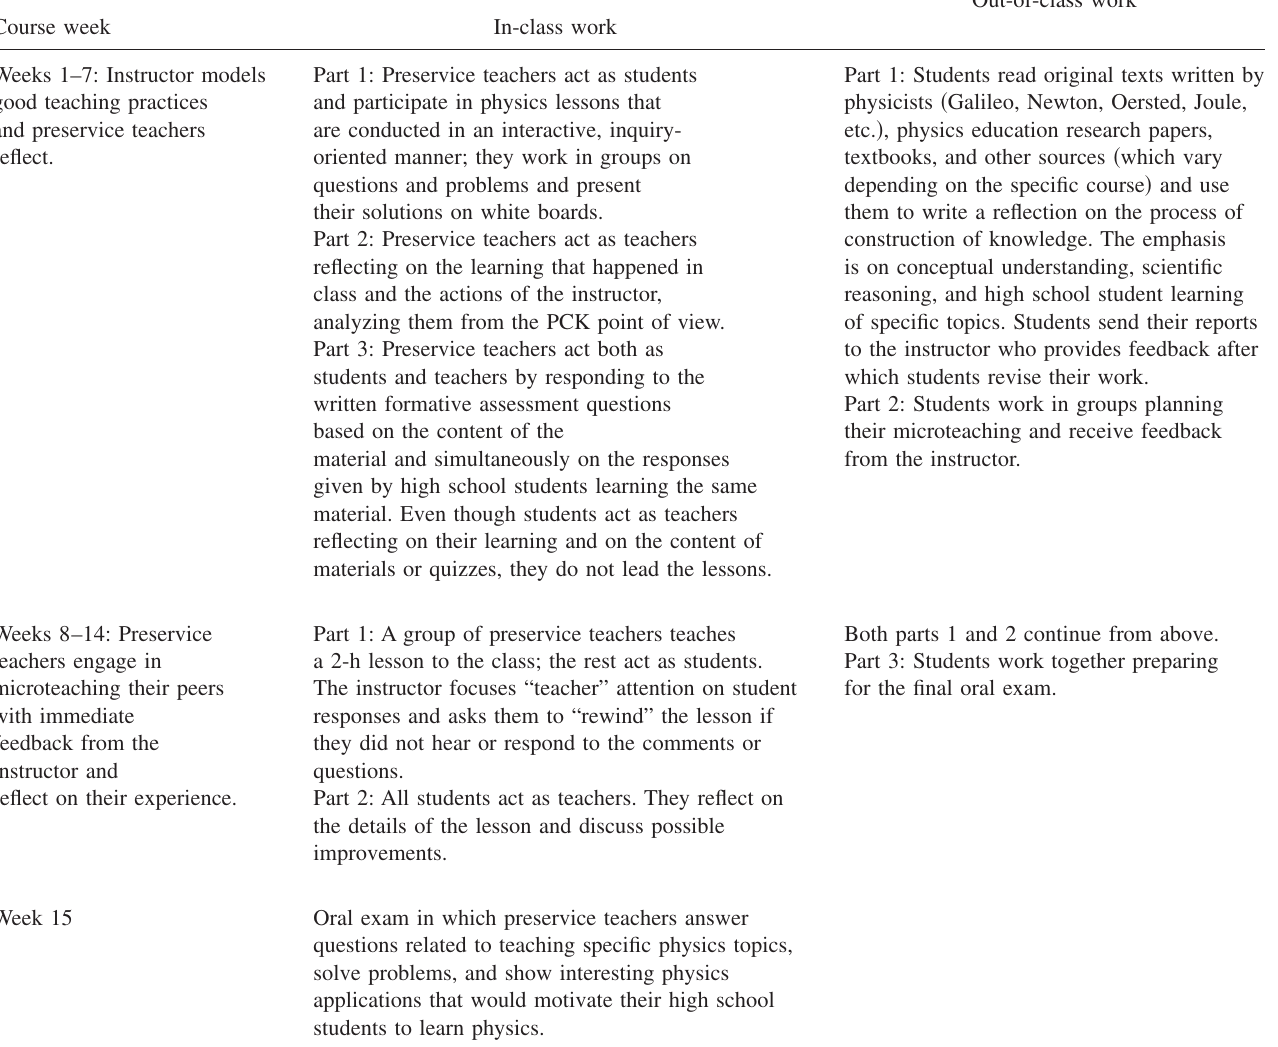
TABLE IV. Repeated elements of physics PCK